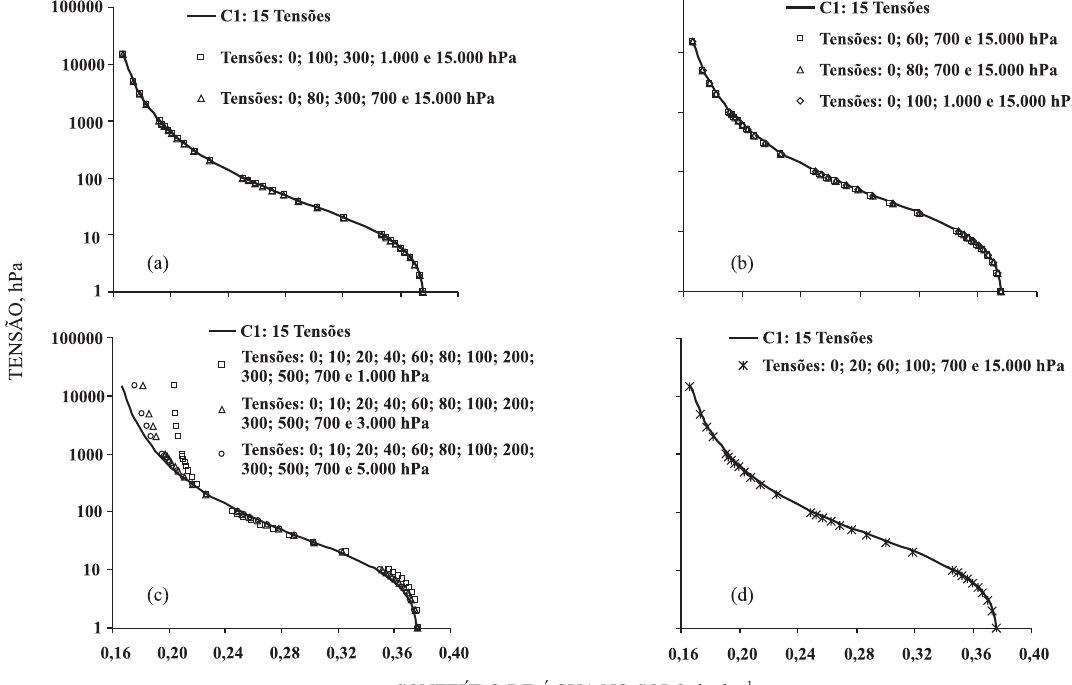
Figura 2. Curvas de retenção de água no solo com: (a) todos os parâmetros iguais aos da curva C1; (b e d) com pelo menos um dos parâmetros diferentes dos de C1; e (c) com todos os parâmetros diferentes dos de C1, ajustados pelo modelo de van Genuchten